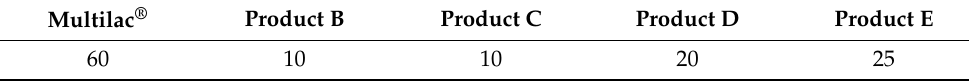
Table 2. Capsule disintegration time in hydrochloric acid at pH 2 in minutes.